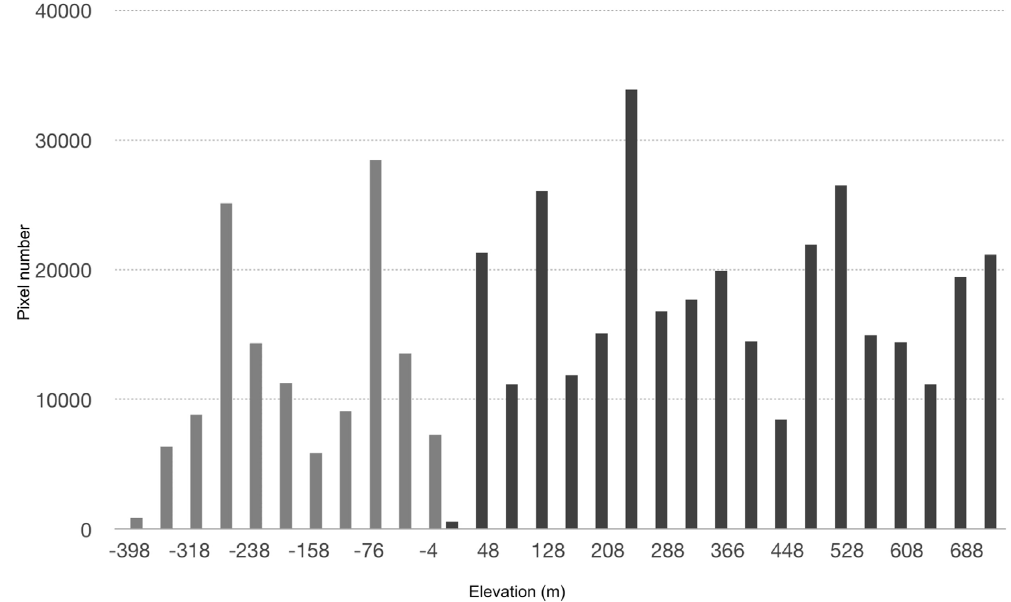
Figure 3. Distribution of subaerial and elevations.